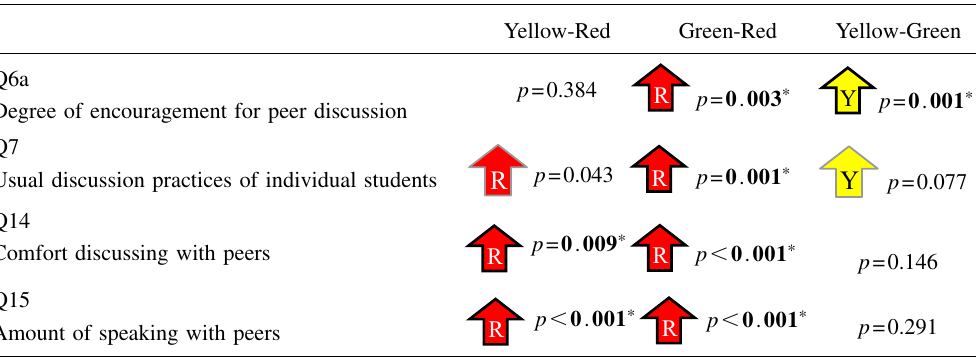
TABLE IV. (cid:1) Color (cid:2) Mann-Whitney U Test Results for Pairwise Comparisons on Student-Student Col- laboration Survey Questions. The arrows in the table indicate which group tends to yield higher (cid:1) more favorable (cid:2) responses for all p -values less than 0.1. Bold font (cid:1) with astrik (cid:2) indicate statistically significant